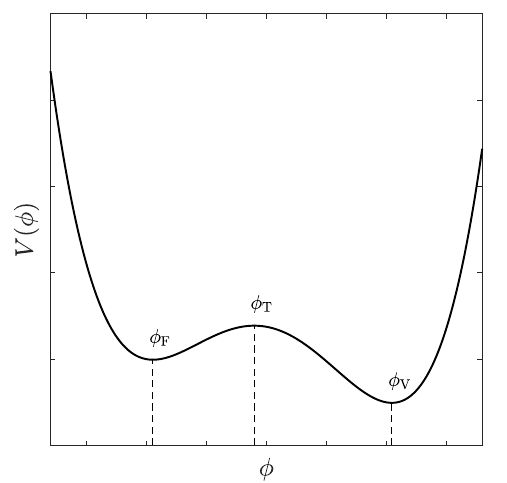
Figure 1 . An example potential containing a true and a false vacuum, located at (cid:30) V and (cid:30) F respectively, separated by a barrier peaked at (cid:30) T